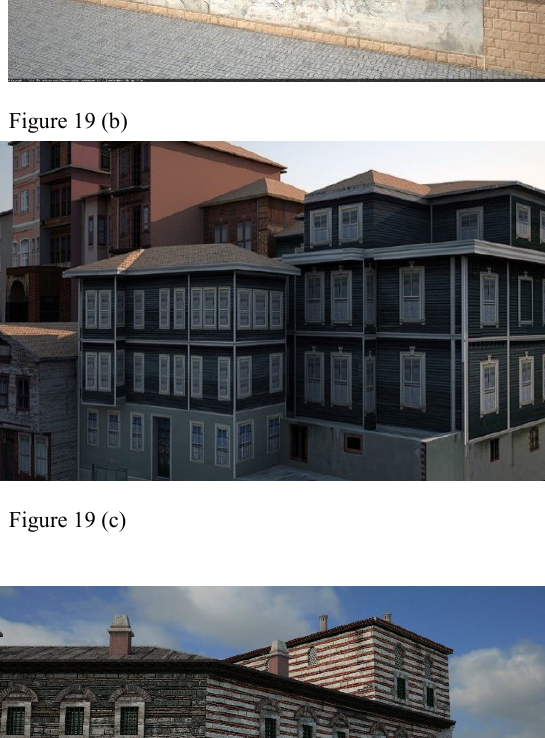
Figure 18: The combined view of points cloud and panoramic imagery of same location in